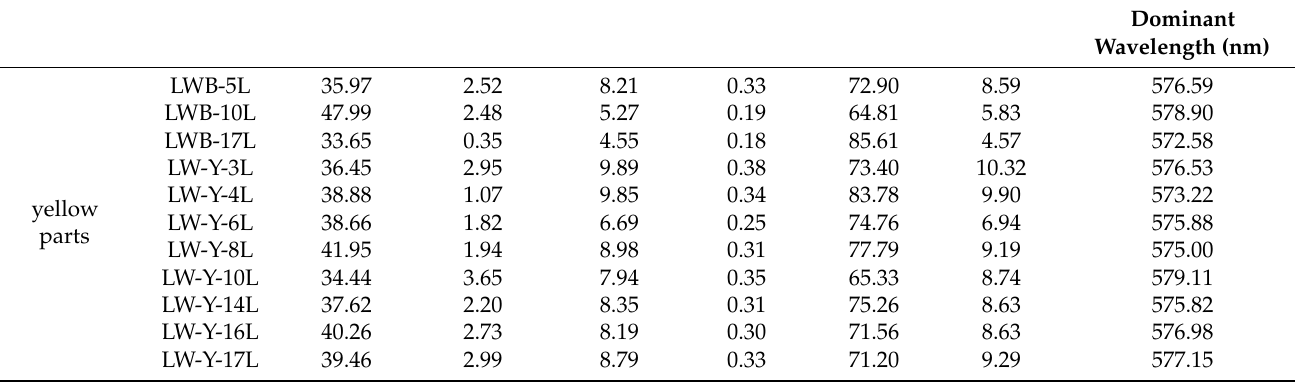
Table 1. Colour parameters collected from the